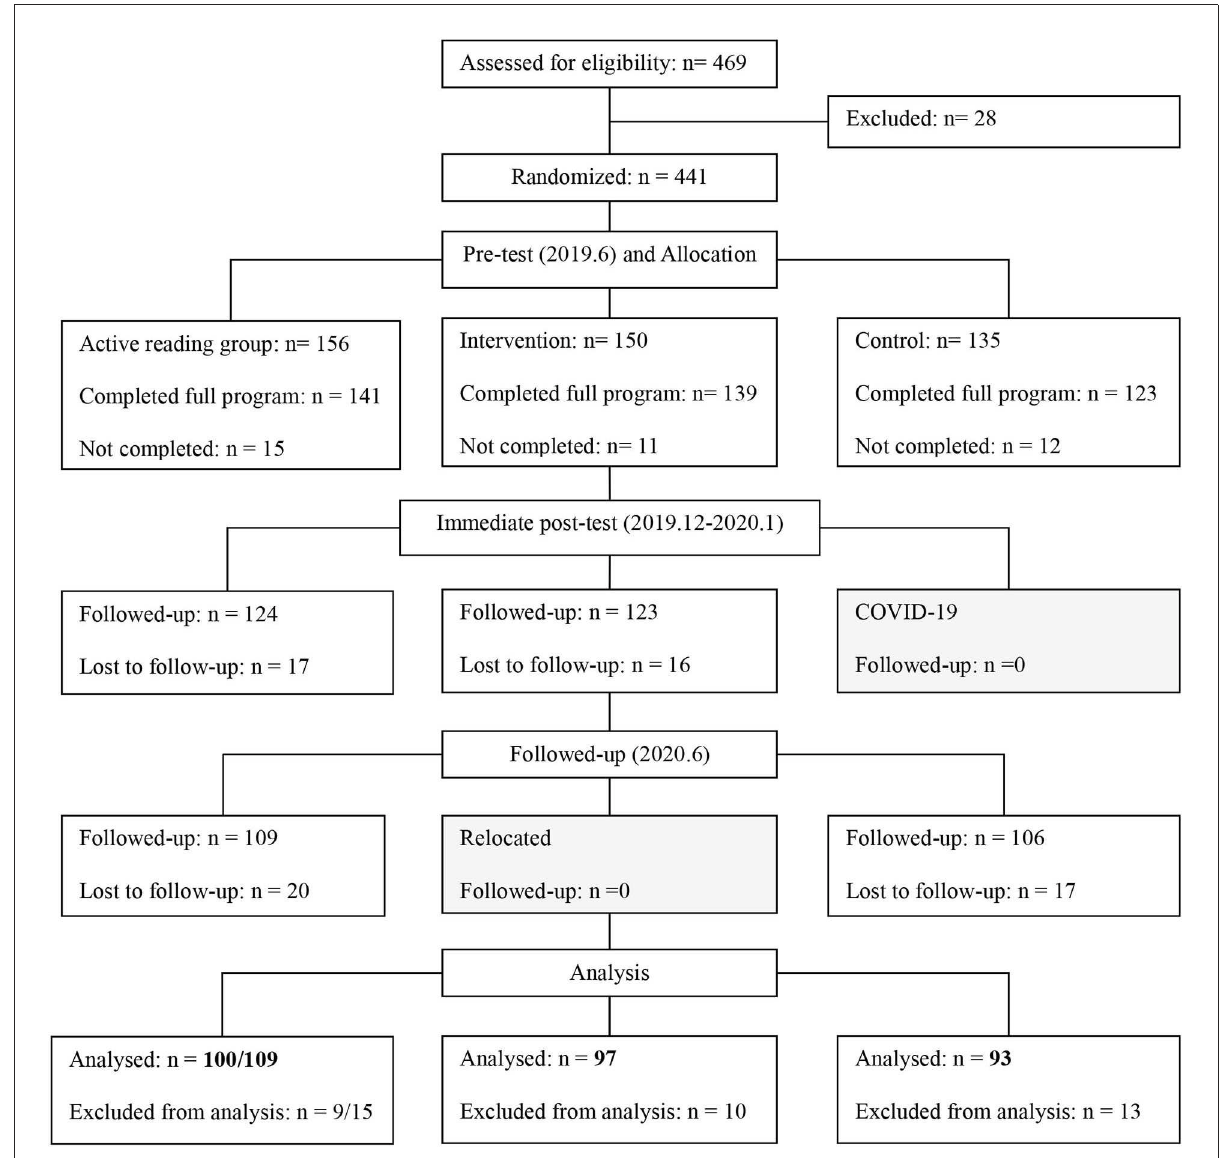
FIGURE1 The consolidated standards of reporting trials of this study. For active reading group, n (T1) = 156, n (T2) = 124, n (T3) = 109; For intervention group, n (T1) = 150, n (T2) = 123; For control group, n (T1) = 135, n (T3) = 106; In our final analyses, we compared active reading group ( n = 109) and intervention group ( n = 97), active reading group ( n = 100) and control group ( n =